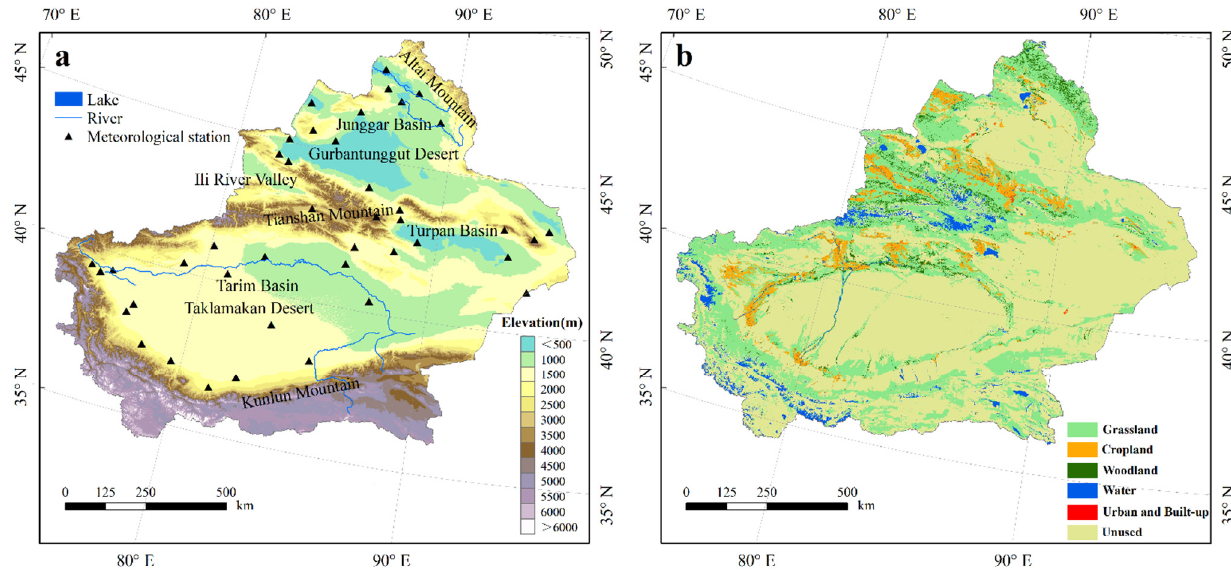
Figure 1. ( a ) Meteorological stations in Xinjiang overlaid on the terrain map (Shuttle Radar Topography Mission; https://eospso.gsfc.nasa.gov/missions/shuttle-radar-topography-mission, accessed on 8 February 2021). ( b ) Land use types in 2010 in Xinjiang (http://www.resdc.cn/, accessed on 2 March 2021).